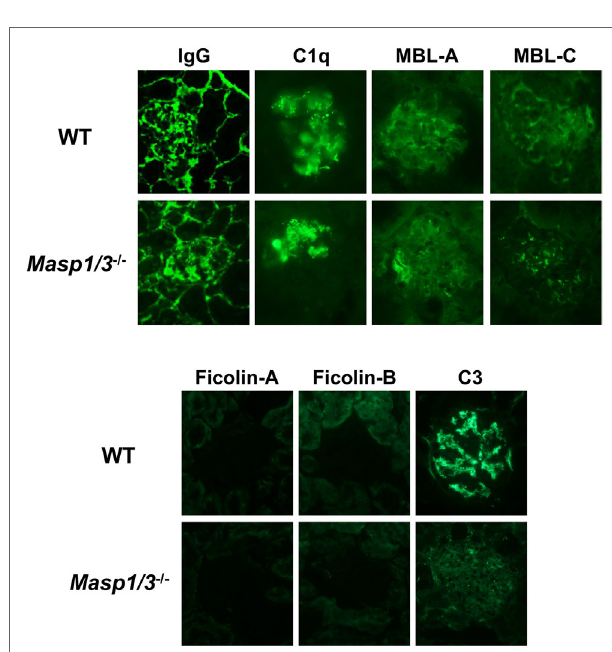
FigUre 5 | Assessment of glomerular depositions of IgG and complement components. Glomerular depositions of IgG, C1q, MBL-A, MBL-C, Ficolin-A, Ficolin-B and C3 were evaluated using kidney sections from 24-week-old WT and Masp1/3 − / − MRL/ lpr mice. Similar results were obtained from five independent mice in each group, and representative images were shown here. Original magnification 400 ×